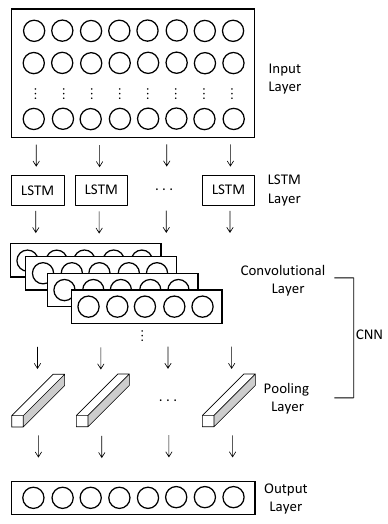
Figure 1. Structure of LSTMconv model (based on